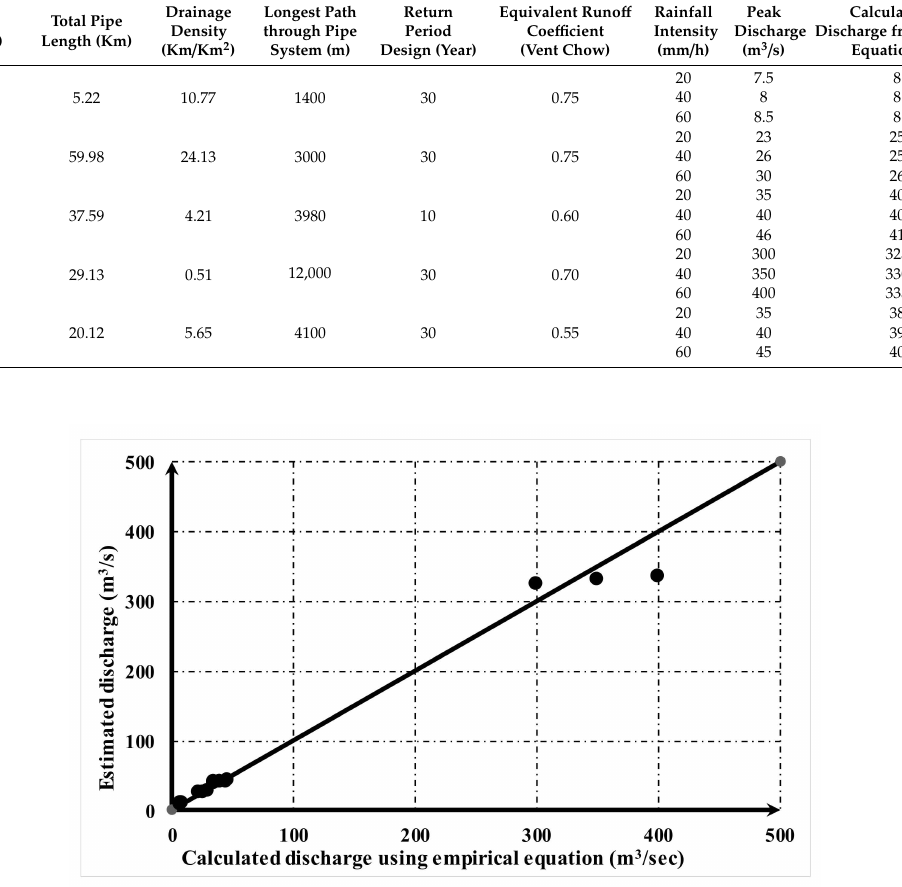
Figure 8. Comparison between calculated discharge using empirical equation and estimated